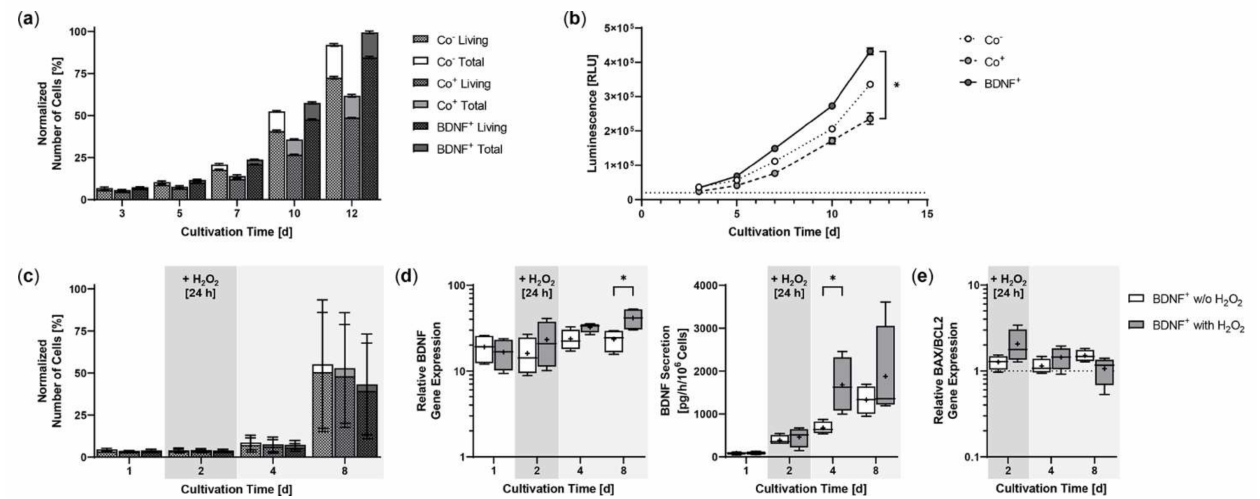
Figure 3. Growth behavior of BDNF-transfected ARPE-19 cells without or after H 2 O 2 -induced oxidative stress compared to non-transfected control cells. In each experiment ( n = 3 for cultures without H 2 O 2 exposure, n = 4 for cultures with H 2 O 2 exposure), non-treated cells (Co − ), cells exposed to the electric field without plasmid DNA (Co + ), and BDNF-transfected cells (BDNF + , transfected with 0.03 µ g SB100X transposase and 0.47 µ g BDNF transposon plasmid) were seeded at an initial density of 2 × 10 4 cells. ( a ) Without H 2 O 2 exposure, individual cultures were terminated after 3, 5, 7, 10, and 12 days. Proliferation was determined by classifying live cell count and total cell count. All values were normalized to the highest measured value, which was set to 100%. At the end of the experiment, comparison of the number of living cells or total cells showed no significant differences, and within each culture, the differences between live cell count and total cell count were also not significant (Kruskal-Wallis test with Dunn’s multiple comparison test). ( b ) Cell viability was analyzed using a luminescence-based assay. At the end of the experiment, BDNF + cultures showed significantly higher values than the Co + cultures (* p = 0.0219, Kruskal-Wallis test with Dunn’s multiple comparisons